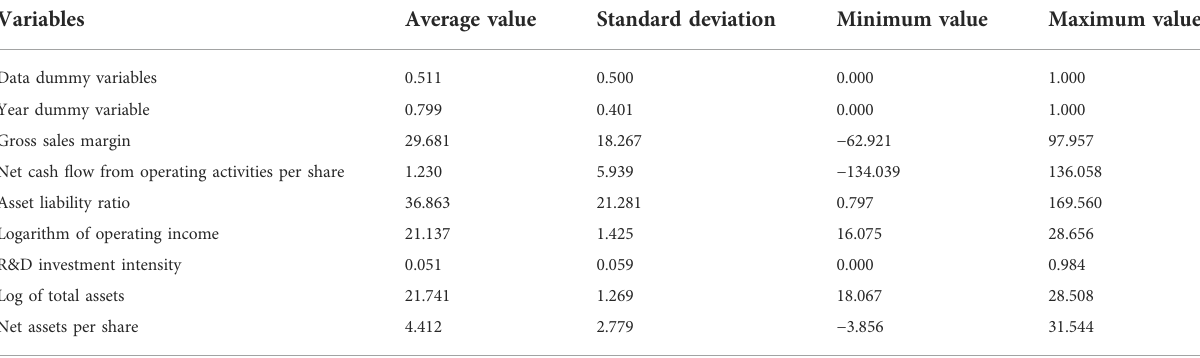
TABLE 5 Descriptive statistics of the main variables.